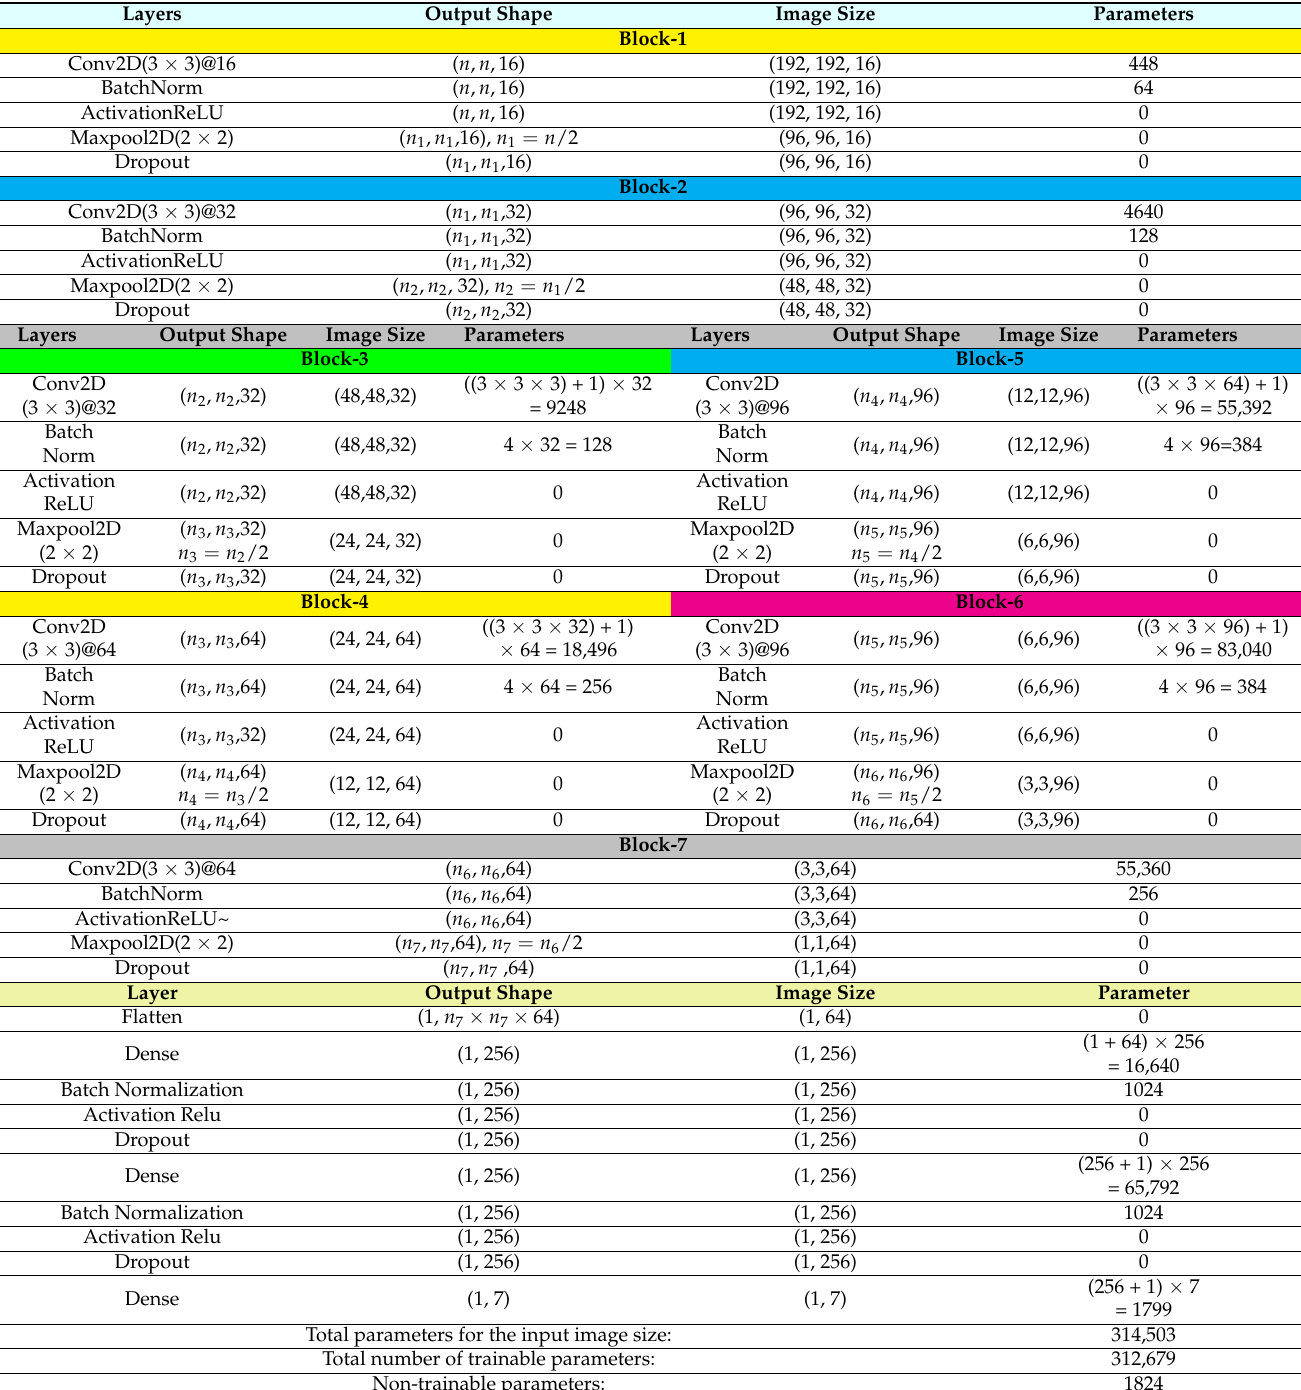
Table 3. The proposed CNN architecture for the input size 192 × 192 with layers, output shape, image size, and parameters.